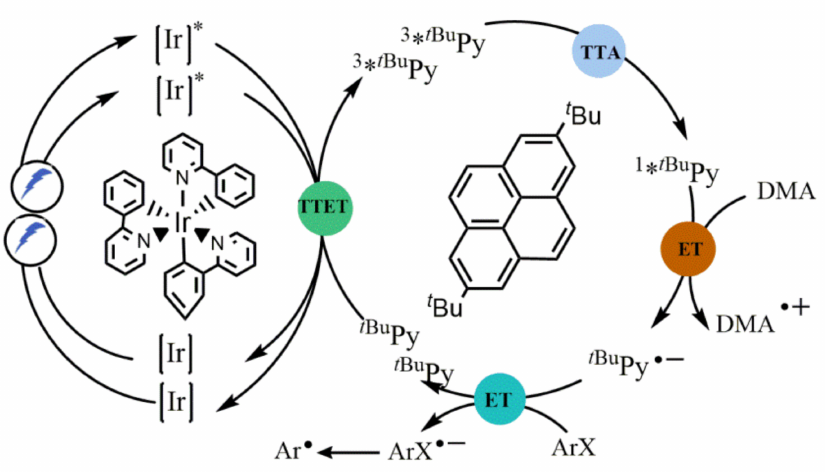
Figure 8. Mechanism for sensitization-initiated electron transfer (SenI-ET) with the fac - [Ir(ppy) 3 ]/ t Bu Py/DMA combination. Reprinted with permission from Ref. [38]. Copyright 2021, Royal Society of